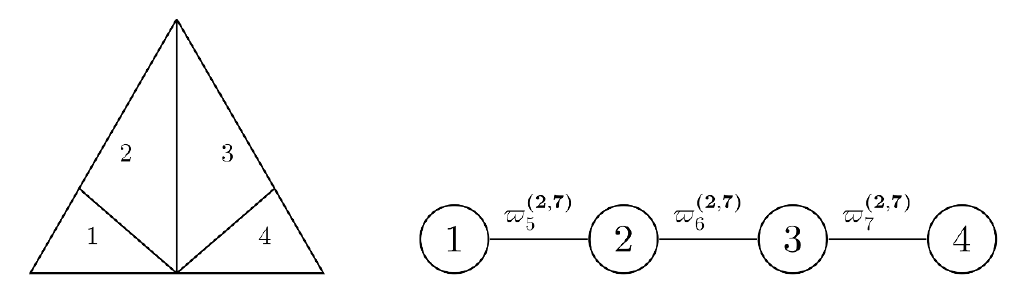
Figure 1 . The chamber structure of I(A (cid:8) g 2 ; 7 )) and its adjacency graph. This also represents 1 2 ; ( the structure of the extended K(cid:127)ahler cone of an SU(2) (cid:2) G 2 -model. Replacing ( 2 ; 7 ) with R = ( 3 ; 1 ) (cid:8) ( 1 ; 14 ) (cid:8) ( 2 ; 7 ) (cid:8) ( 2 ; 1 ) (cid:8) ( 1 ; 7 ) does not change the adjacency graph since the adjoint and fundamental representations do not intersect the interior of the Weyl chamber of A 1 (cid:8) g 2 . The interior walls are given by the weights $ ( 2 ; 7 )